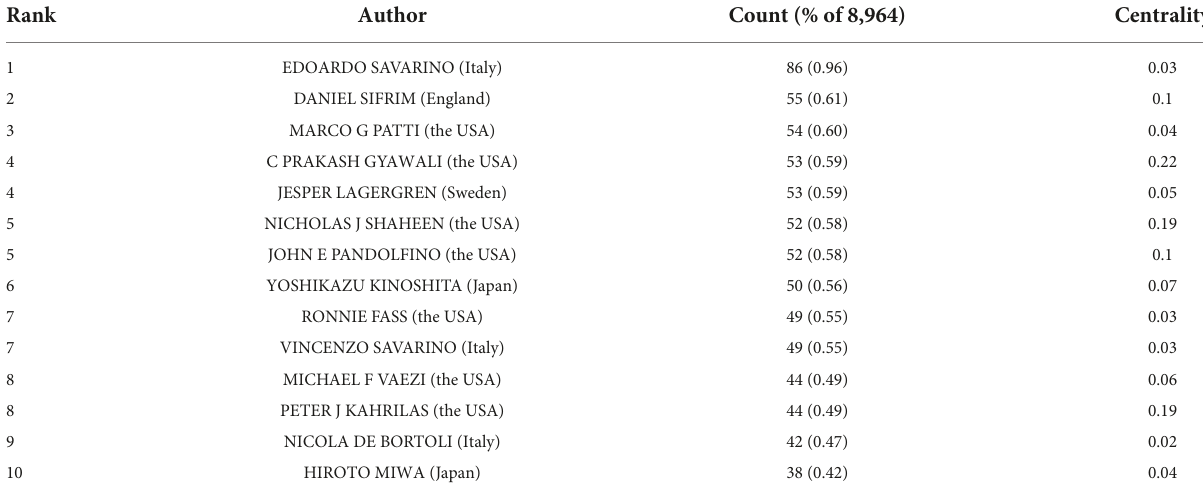
TABLE 2 The top 10 authors in GERD